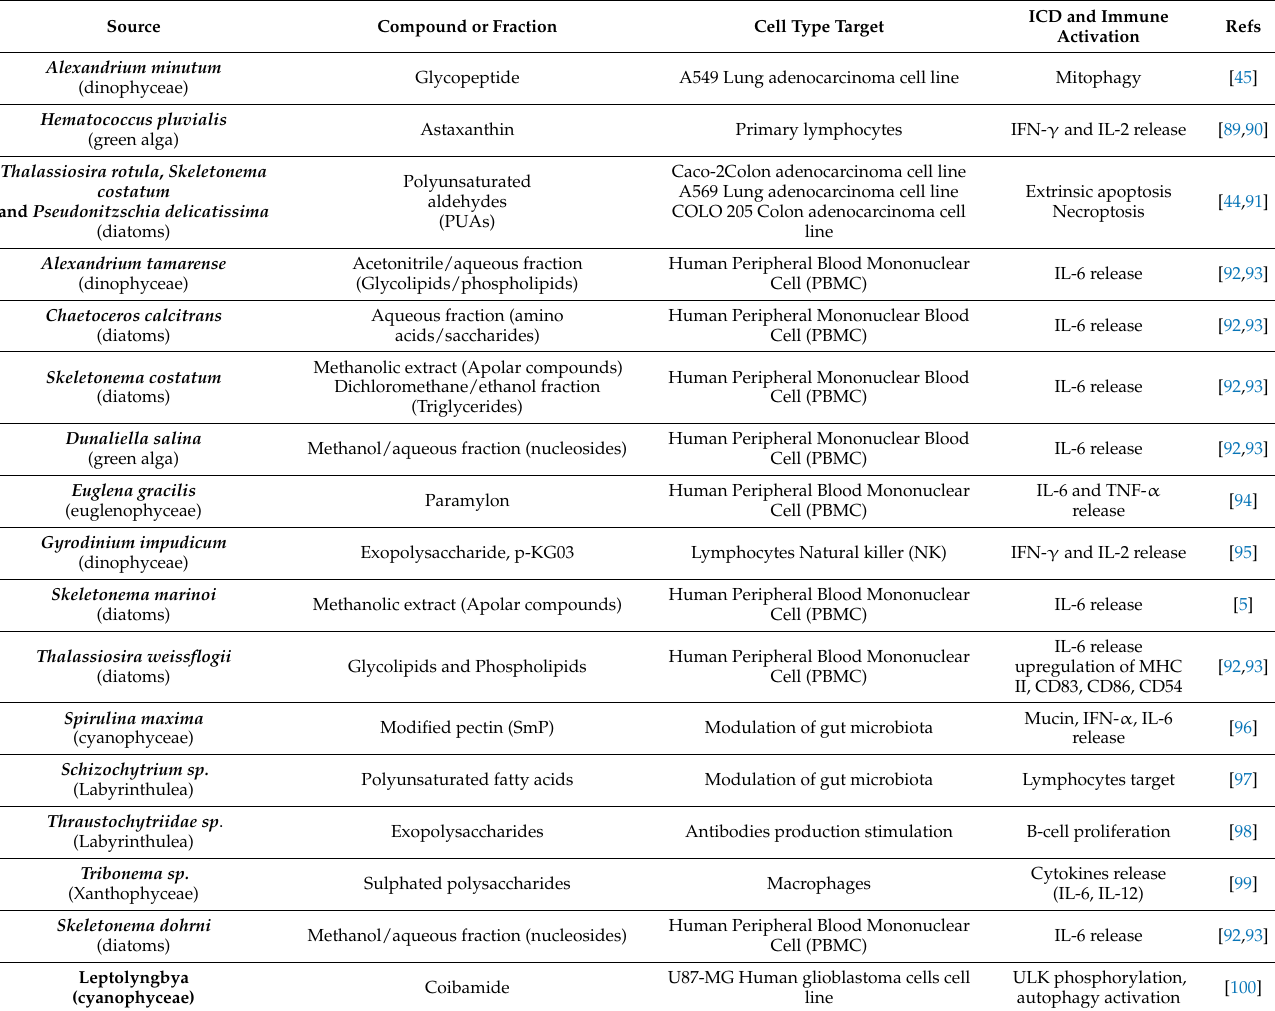
Table 2. Marine organisms and relative immunomodulating molecular mechanisms. Selected marine organisms and related immunomodulating activities are shown, clustered for tumour cell type target and immunomodulating